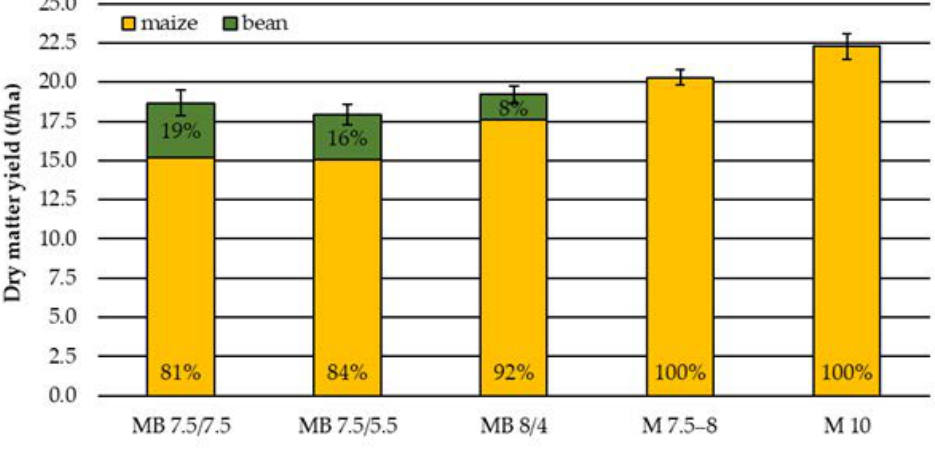
Figure A1. Proportions of maize and bean (%) in dry matter